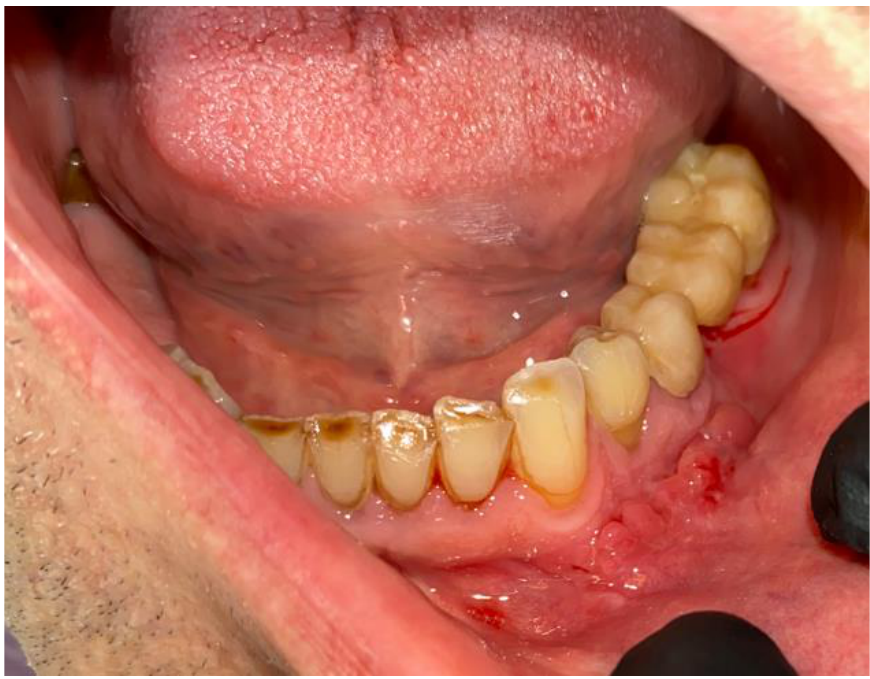
Figure 9. Final view of the operated area after 14 days during suture removal.